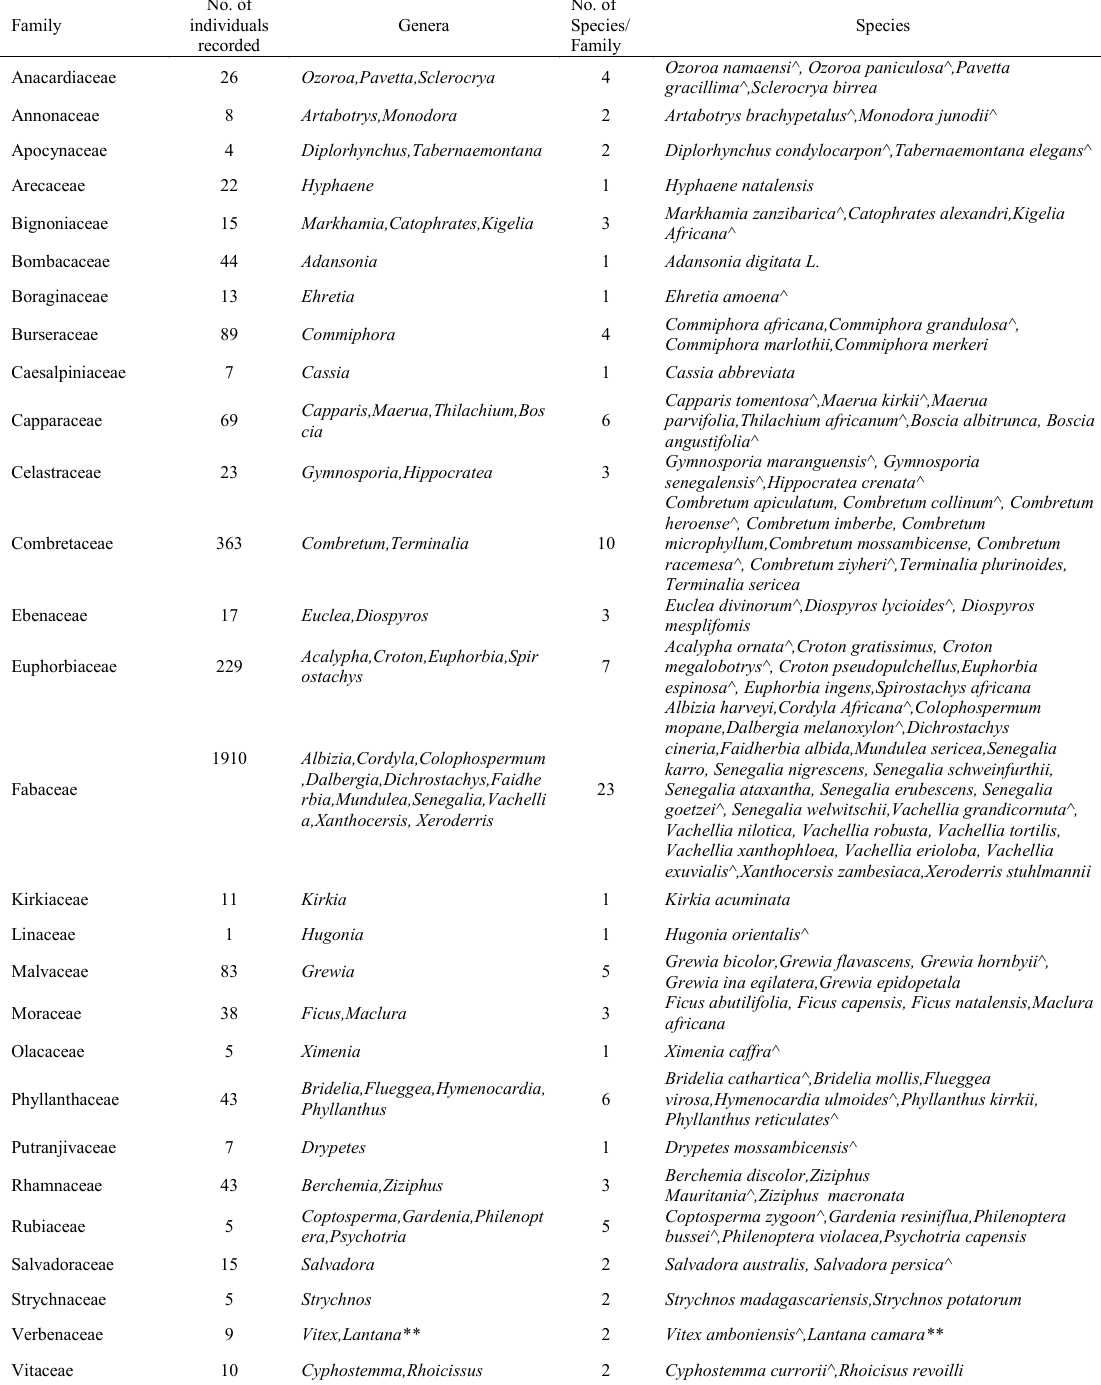
Table 3: Number of individuals per family and species recorded in Mapungubwe Cultural Landscape